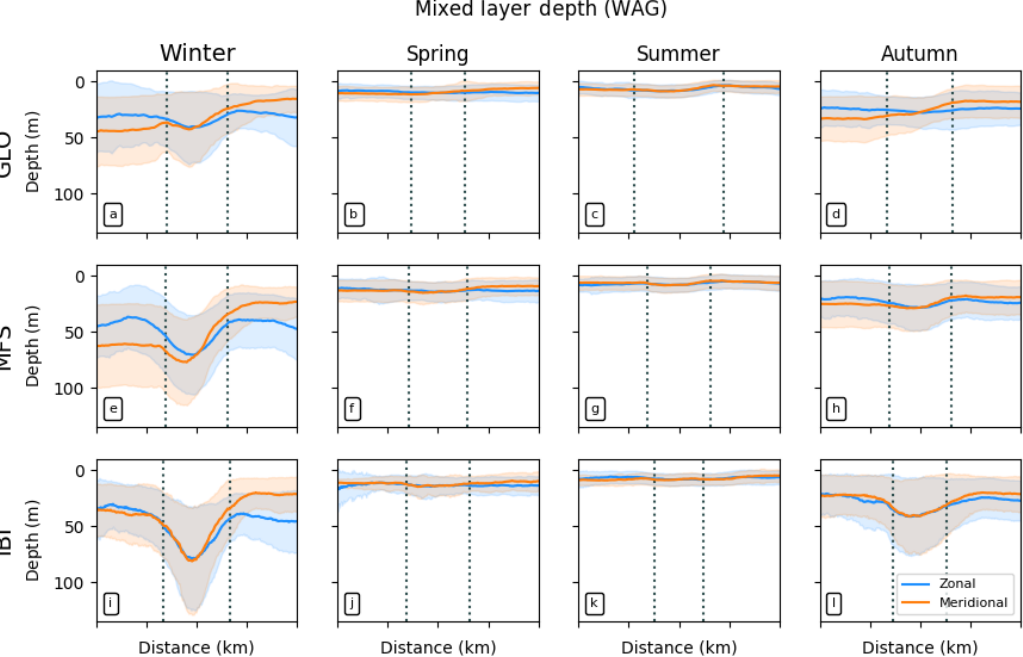
Figure 10. Mean and standard deviation of the seasonal mixed layer depth in anticyclones in the Western Alboran Gyre for GLO (top row), MFS (middle row) and IBI (bottom column). Zonal (meridional) profiles are in blue (orange). Vertical dotted lines mark the mean eddy radius from the